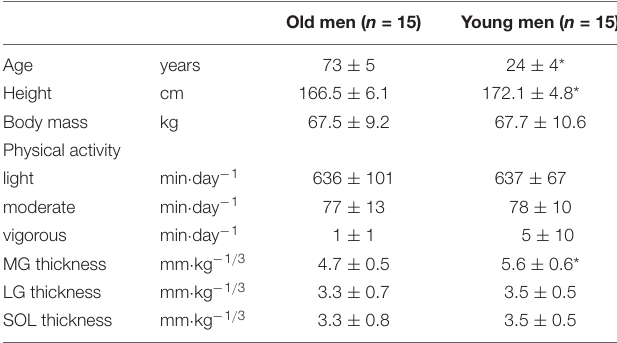
*Indicates the significant difference between older and young men. LG, lateral gastrocnemius; MG, medial gastrocnemius; SOL, soleus. Data are shown as mean ± standard